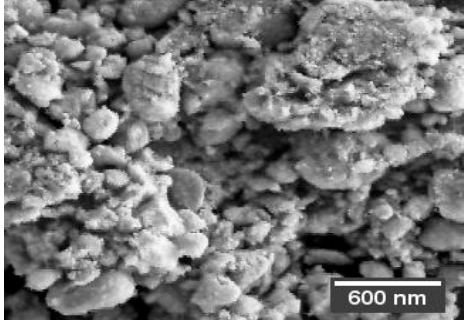
Figure 2. Scanning electron microscopy (SEM) image of ZrO 2 NPs.